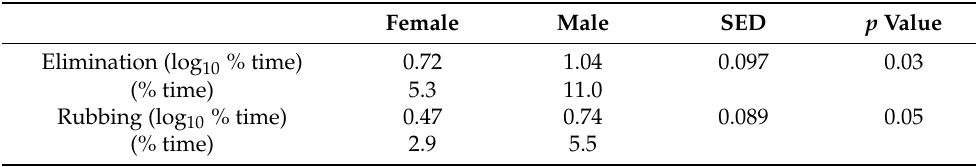
Table 4. Significant effects of gender on horse behaviour.